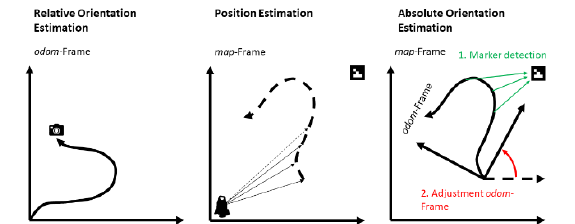
Figure 3. Concept of the three parts of the absolute orientation estimation: relative orientation (left), position (centre) and absolute orientation (right) with the respective reference